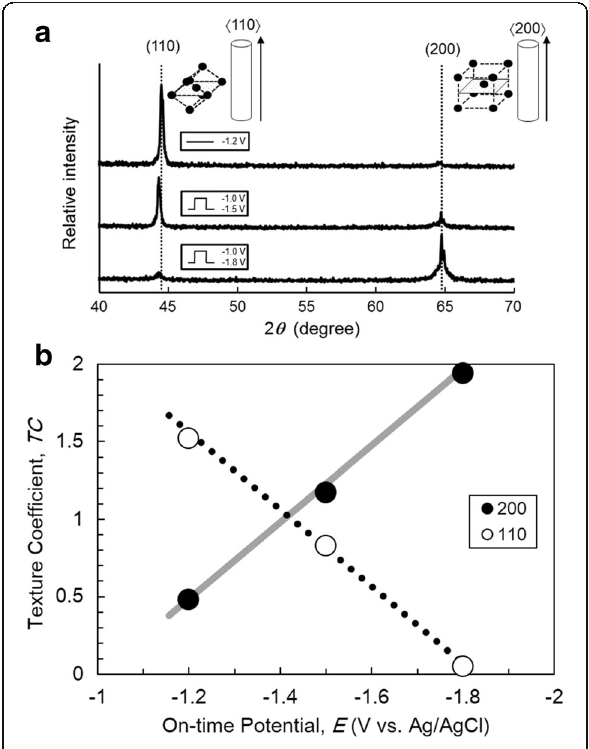
Fig. 7 Crystal orientation and morphology of Fe nanowire arrays. a X-ray diffraction patterns. b On-time potential